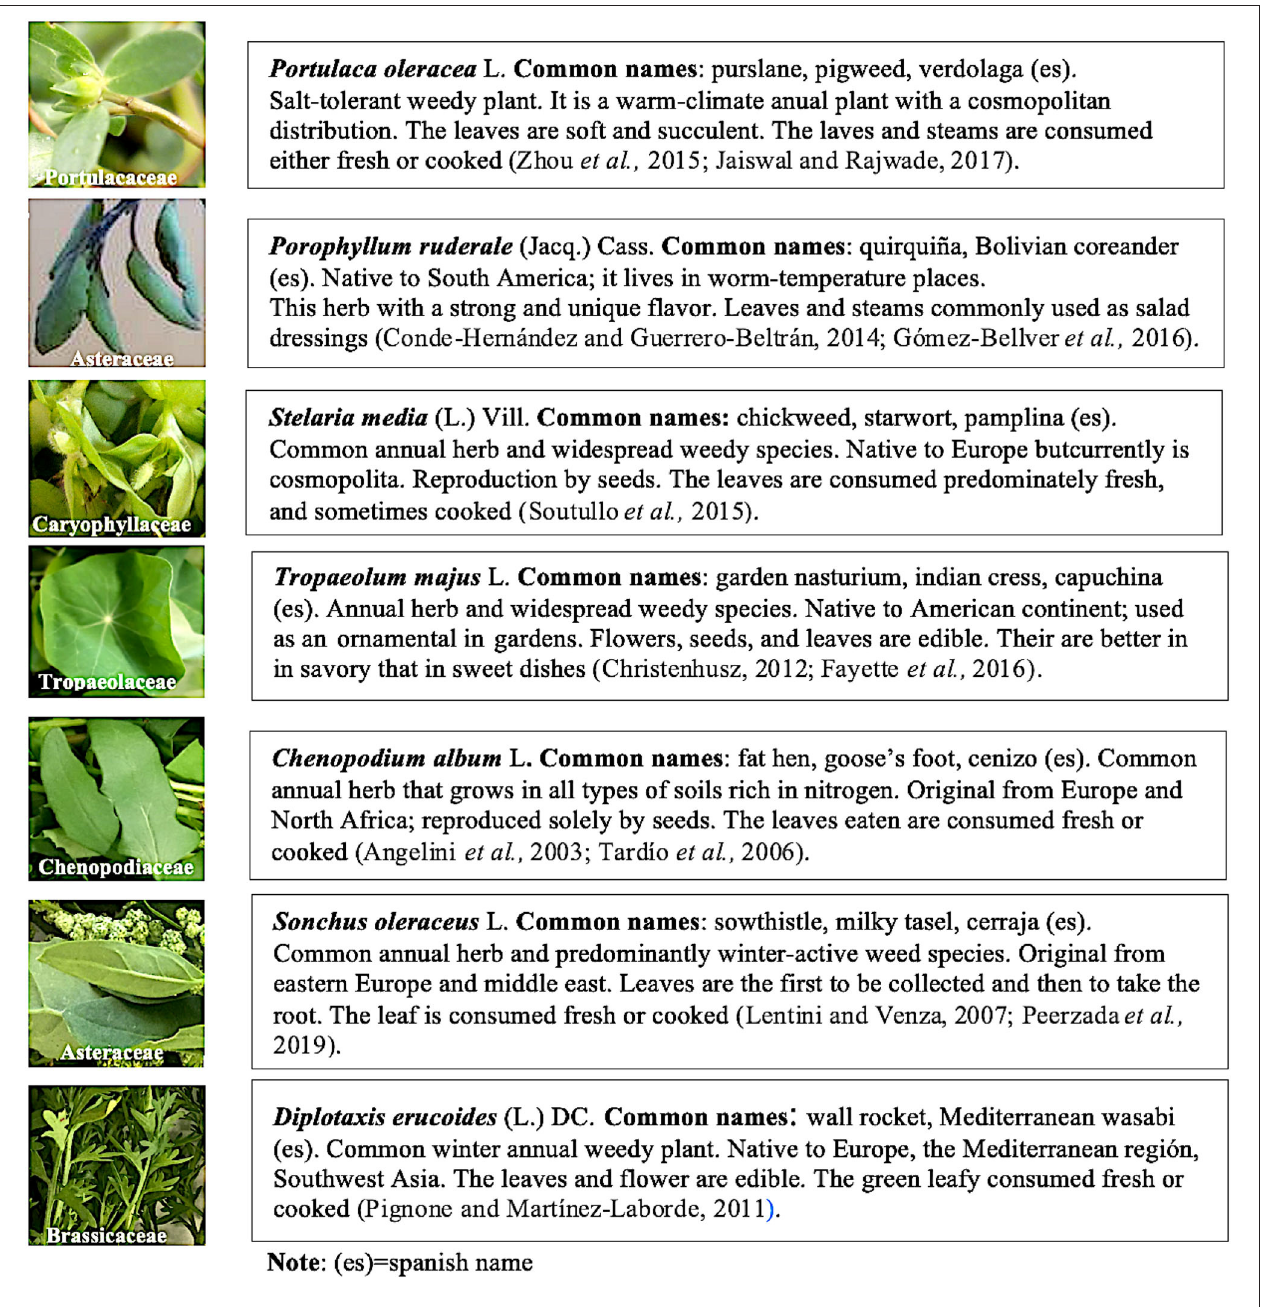
FIGURE 1 | Botanical families and a brief description of the seven wild edible species selected for study.